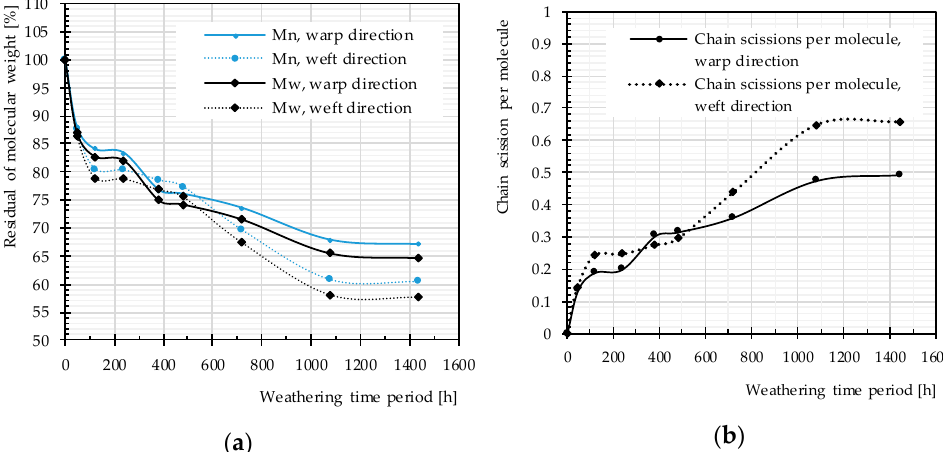
Figure 13. Different artificial weathering durations (Method M4), uncoated PET Type II: ( a ) molecular weight changes; and ( b ) chain scission changes.